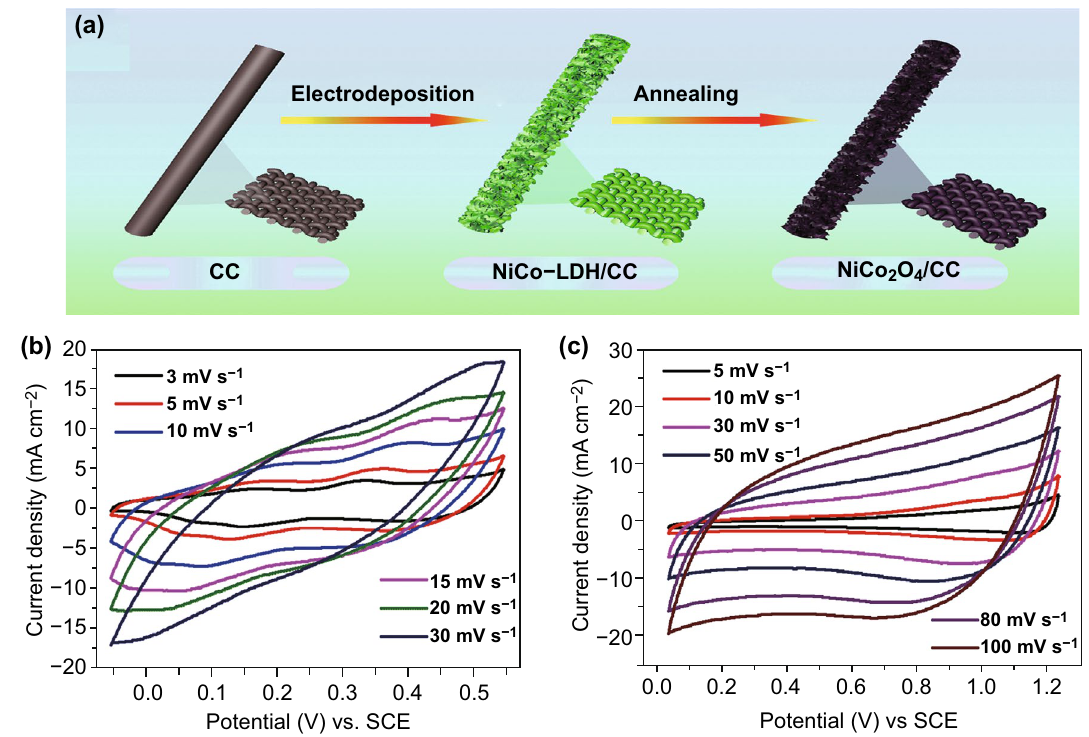
Fig. 5 a Schematic illustration of the fabrication process of the NiCo 2 O 4 /CC composite. The CV profiles of the as‑fabricated NiCo 2 O 4 /CC electrode at a three‑electrode system b in alkaline electrolyte and c in neutral electrolyte with different scan rates. Adapted with permission from Ref.